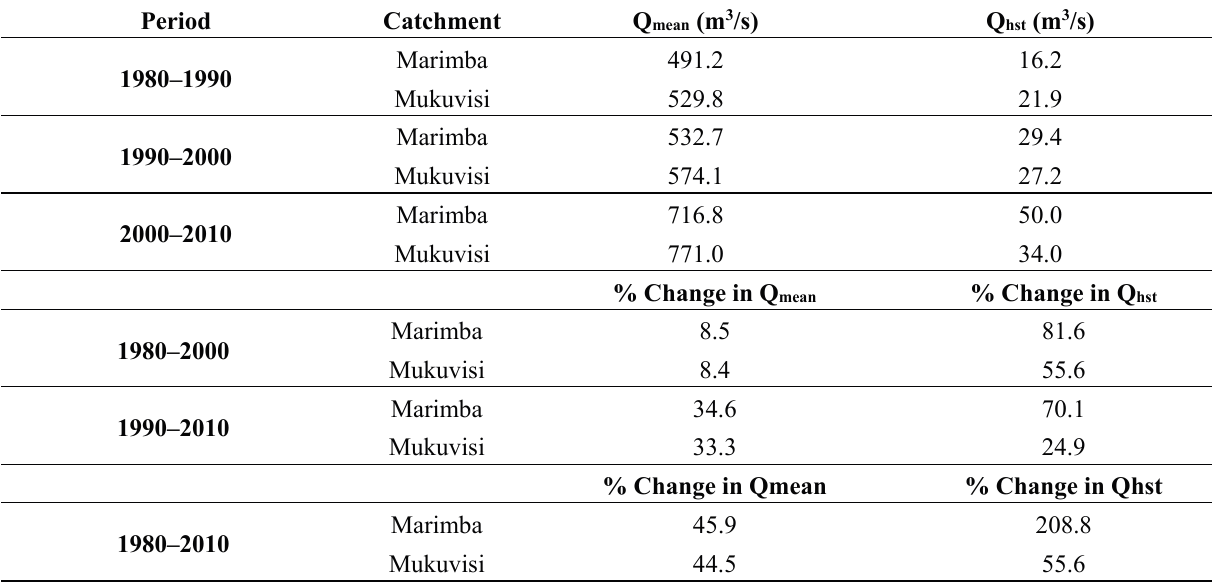
Table 14. Comparison of simulated Mean Annual Streamflow (Q mean ) and Yearly Highest Streamflow (Q hst ) for respective